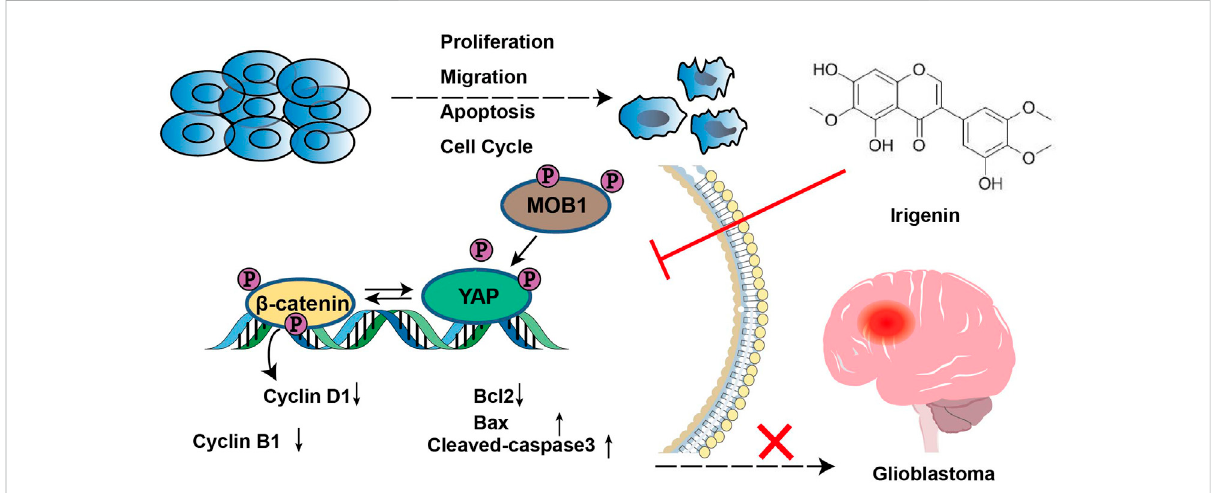
FIGURE 9 AworkingmodelofirigenininGBMcells.IrigenintreatmentinhibitedtheYAP/ β -cateninpathwayinGBMcells,whichmayresultininhibitingthe tumorigenesis, including inhibition of cell proliferation, suppression of the migration, and induction of the apoptosis both in vitro and in